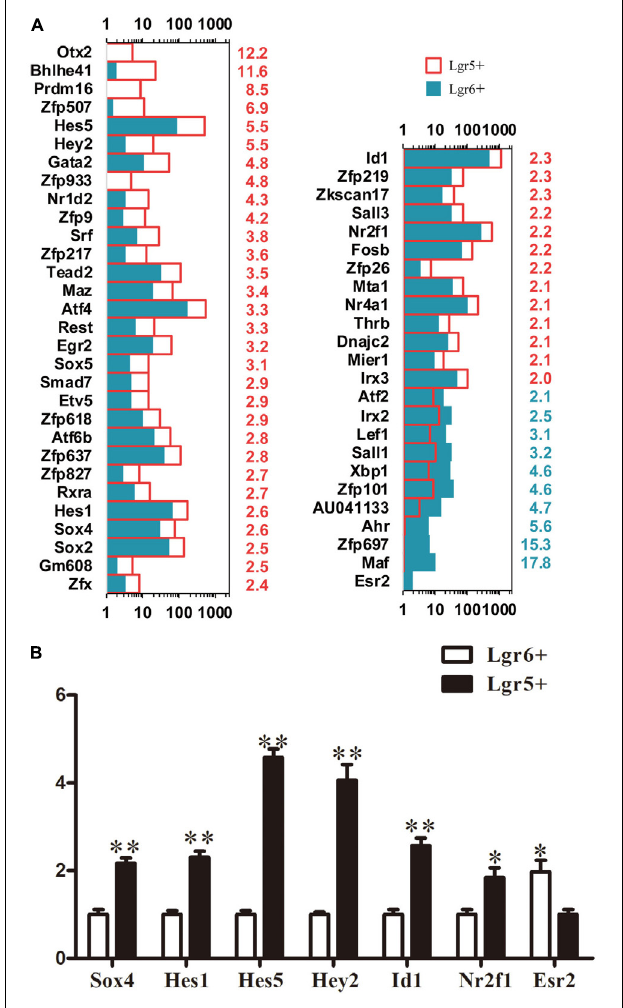
FIGURE 5 | Genes regulating transcription factors. (A) Expression levels of differentially expressed TFs. The number in red on the right of each panel represents the fold difference in expression in Lgr5+ progenitors versus Lgr6+ progenitors, and the number in blue on the right of each panel represents the fold difference in expression in Lgr6+ progenitors versus Lgr5+ progenitors. (B) q-PCR analysis of the TF genes. ∗ p < 0.05, ∗∗ p < 0.01, n = 3.